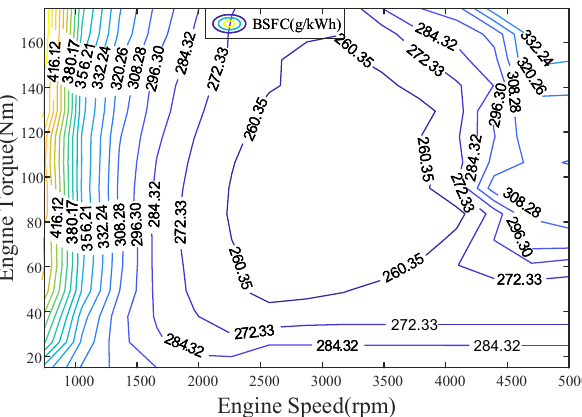
Figure 3. Brake-specific fuel consumption (BSFC) map of the